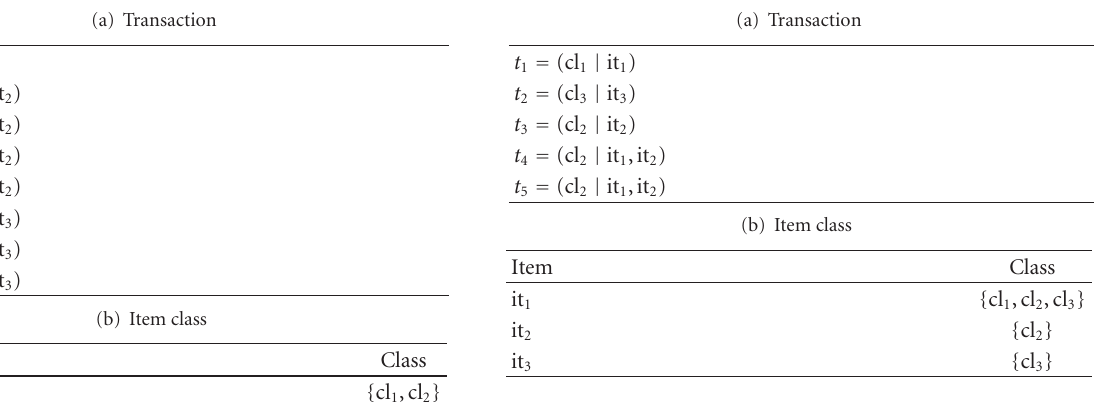
Table 4: An example of transactions and item classes (1). Table 5: An example of transactions and item classes